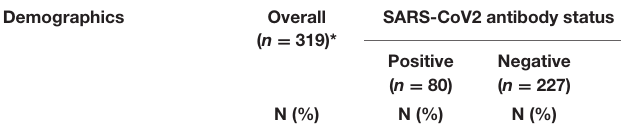
TABLE 2 | Demographics and clinical characteristics, TX CARES, all phase 1 participants,